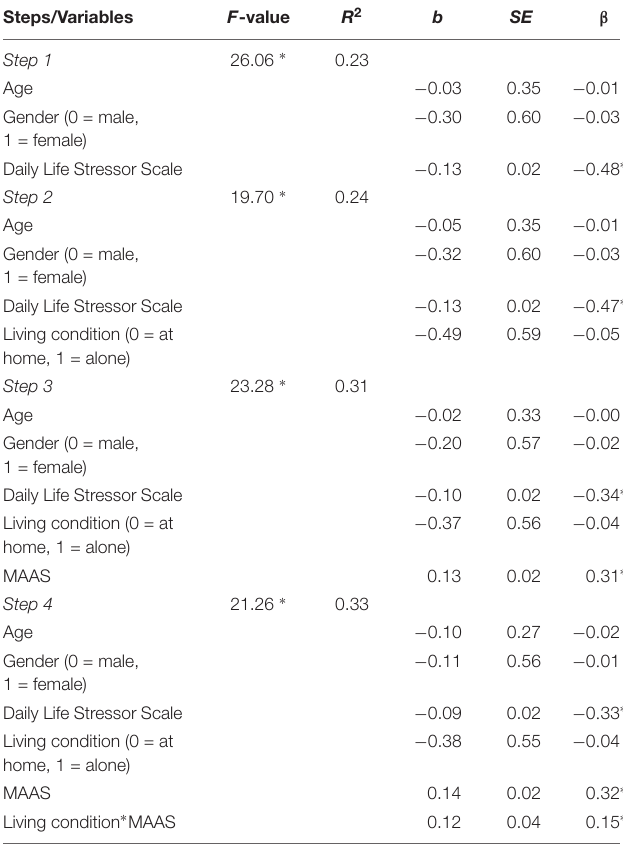
TABLE 2 | Results of the hierarchical multivariate regression